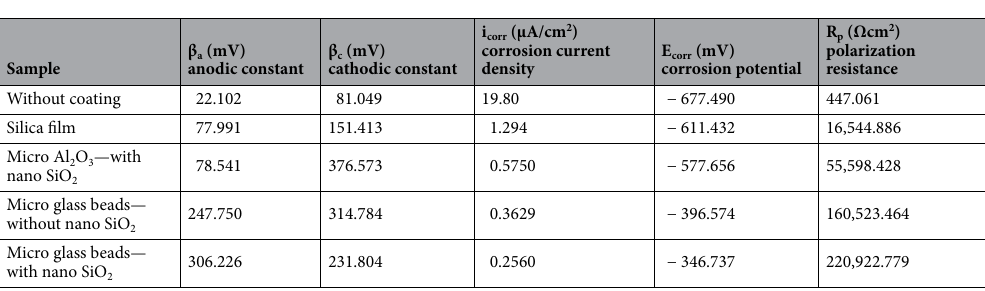
Table 4. Potentiodynamic corrosion test results in 3.5% NaCl